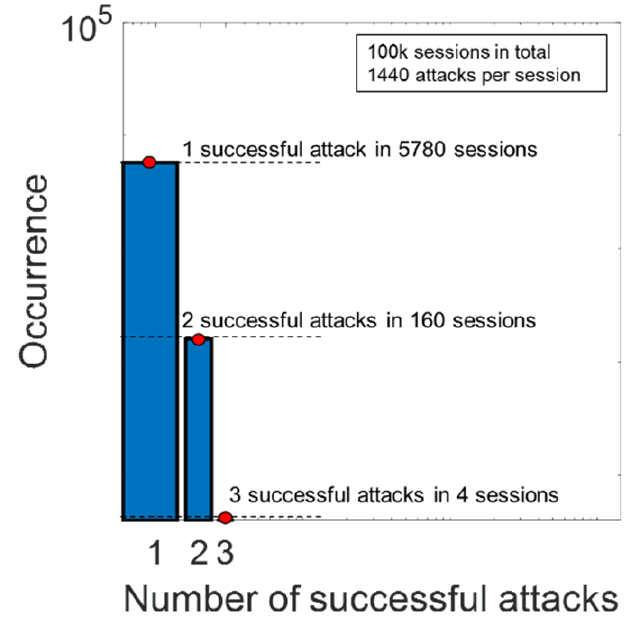
Figure 5. Frequency of successfully hacked trials of 100,000 sessions composed of 1440 attacks (whole dataset).